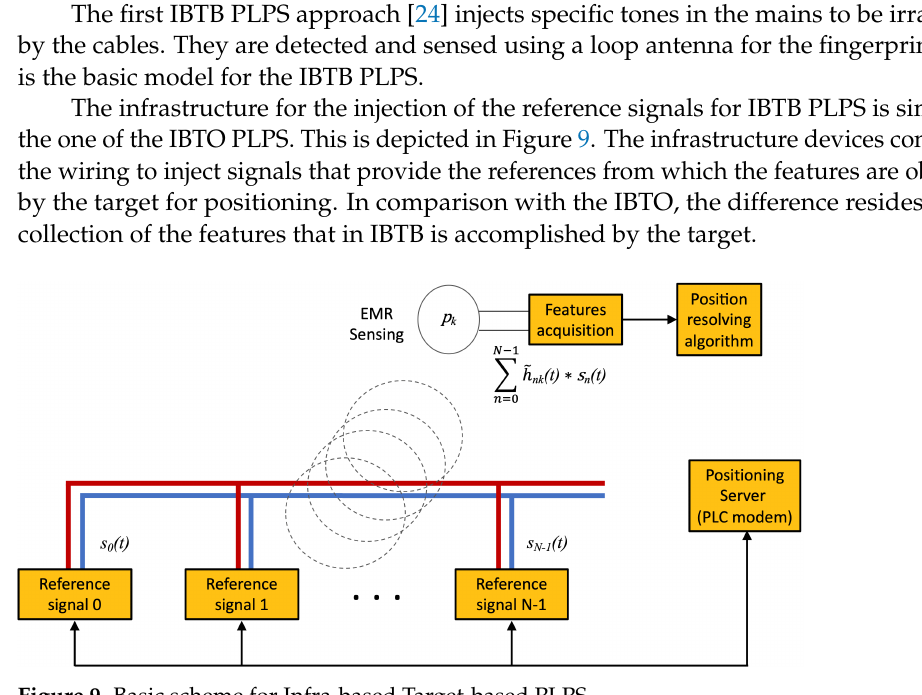
Figure 9. Basic scheme for Infra-based Target-based